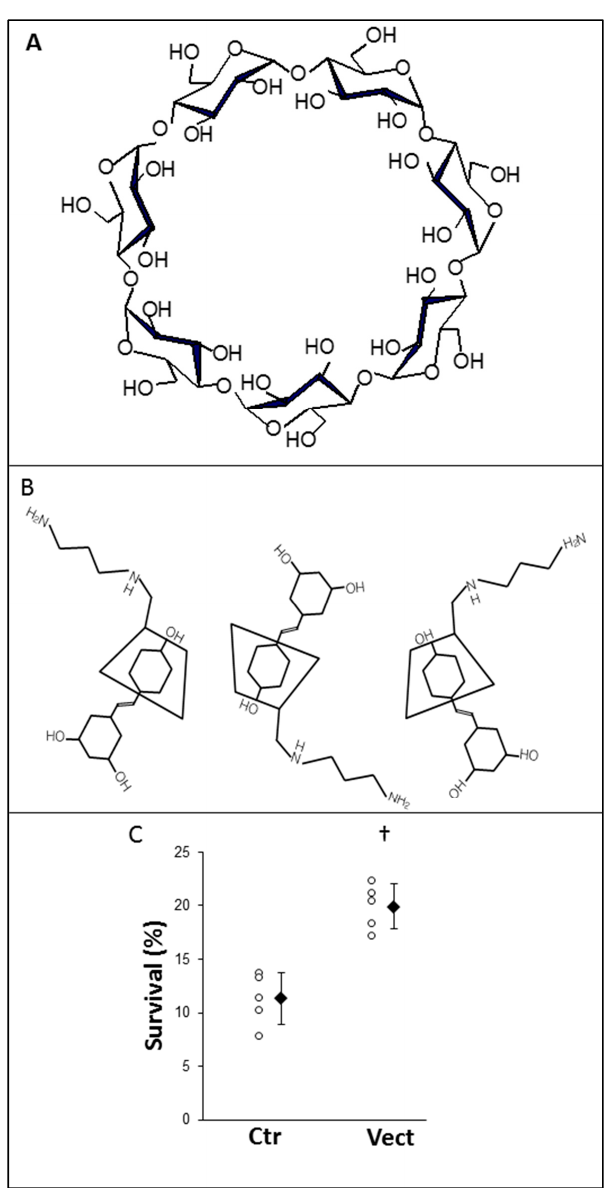
Figure 1. Vectisol ® chemical composition, rationale, and in vitro effectiveness. ( A ) Molecular structure of β -cyclodextrin with seven glucose subunits. ( B ) Schematic representation of the Vectisol ® inclusion complex. ( C ) Cells were subjected to conditions mimicking organ preservation, using a 24 h hypothermia/hypoxia incubation with University of Wisconsin solution, during which Vectisol ® was added in the Vectisol group, followed by a return to normal culture conditions, at which point the cell survival was assessed. Shown are each data point, as well as mean ±SD, statistics (Wilcoxon Test): †: p < 0.05 to Ctr.